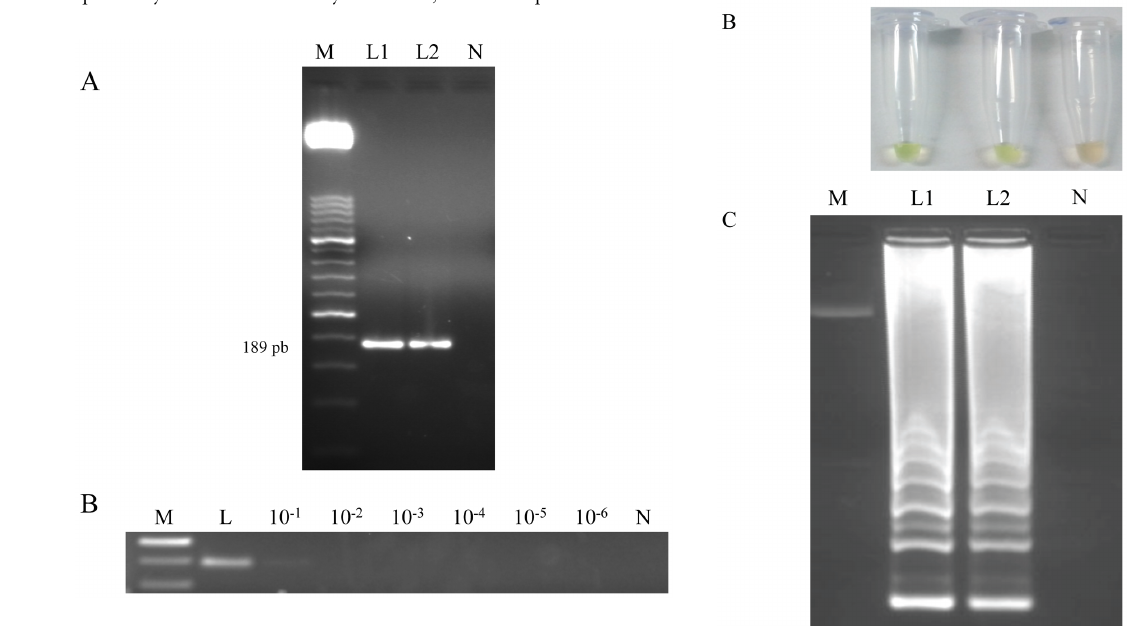
Figure 1. PCR verification and detection limit. (A) PCR verification of expected target length using LAMP outer primers F3 and B3. Lane M, 50 bp DNA ladder (Molecular weight marker XIII, Roche); lanes L1 and L2: Loa loa DNA; lane N, negative control (no DNA template). (B) Detection limit of PCR. Lane M, 50 bp DNA ladder (Molecular weight marker XIII, Roche); lane L: Loa loa DNA (5 ng); lanes 10 2 1 –10 2 6 : 10-fold serially dilutions of L. loa DNA; lane N, negative control (no DNA template).